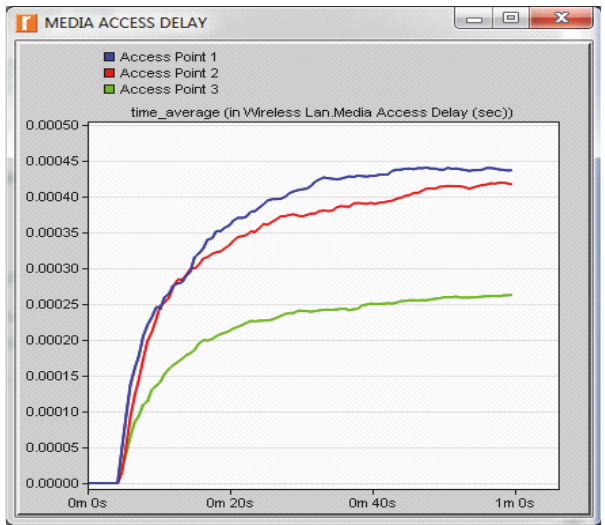
Figure 6: WLAN media access delay of different access points.